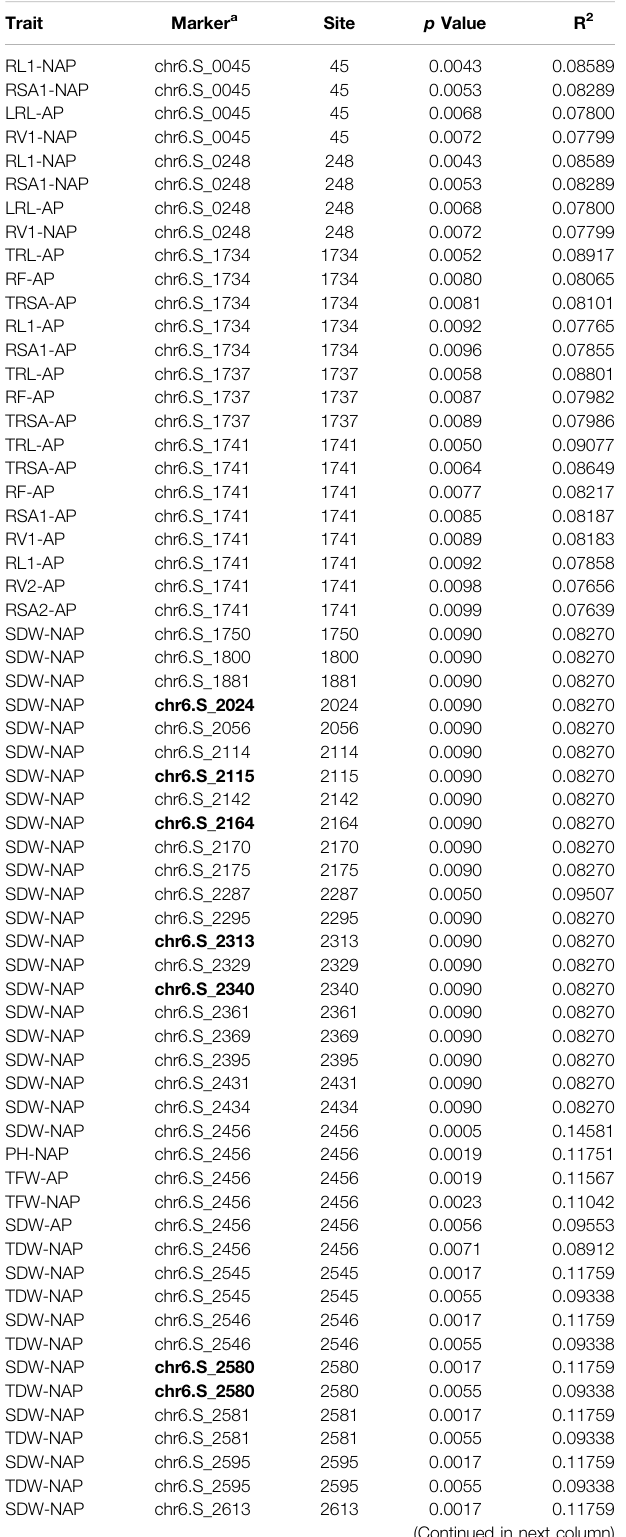
TABLE 2| TheassociationmappingofSNPsand Indels of ZmZFP126 geneswith 19 shoot and root traits in the maize seeding stage under normal afforded phosphorus (AP) and non-afforded phosphorus conditions